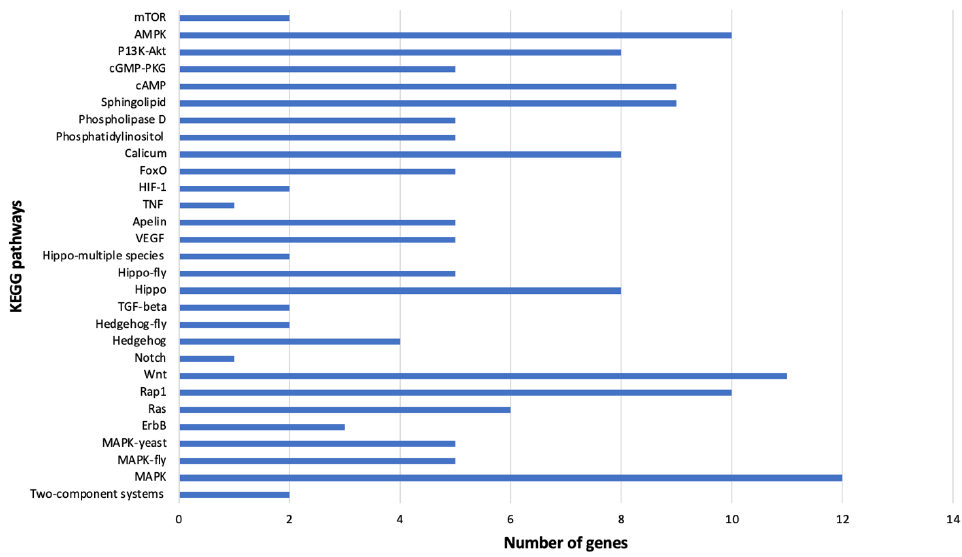
Figure 8. KEGG pathways pertaining to signal transduction identified in viruliferous Bemisia tabaci Middle East-Asia Minor 1. The number of differentially expressed genes involved in each pathway are displayed on the x -axis.